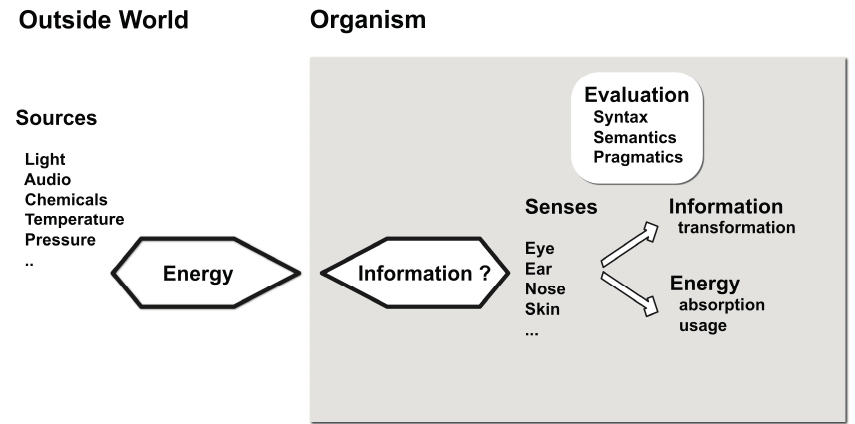
Figure 1. Transformation of energy into information from outside to inside of a biologic organism. Energy is transformed into information via senses and the application of syntactic and semantic rules (by accompanied pragmatics) evaluating energy on its usability as